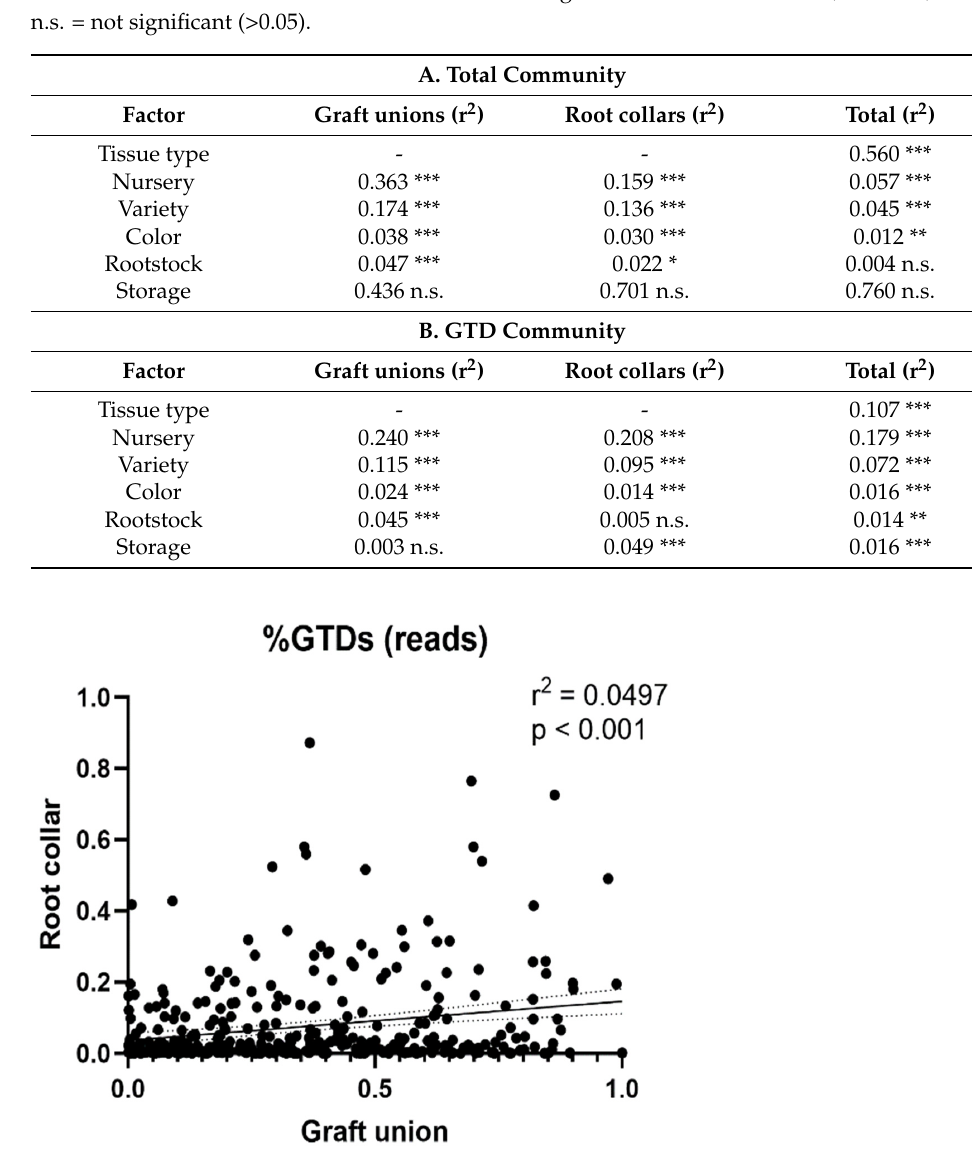
Figure 3. Linear regression of GTD-related OTUs (% reads) in the two tissues: correlation between graft unions and root collars.